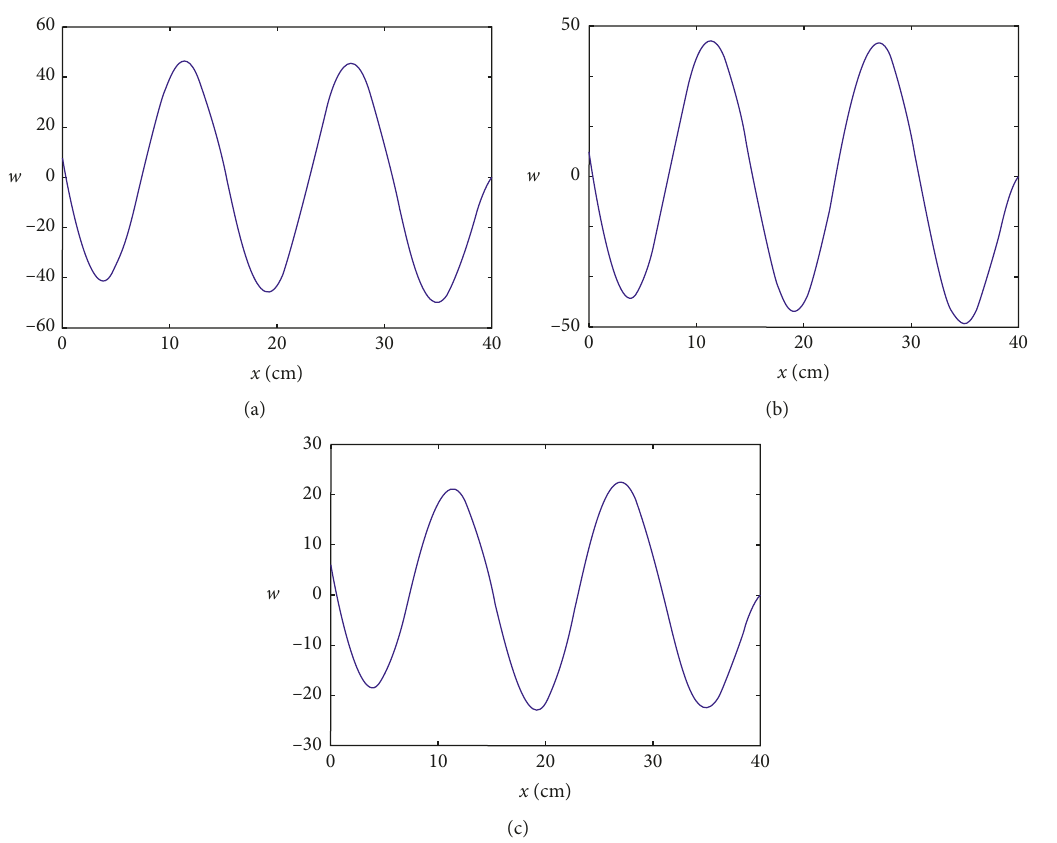
Figure 9: Effects of the damping layer thickness on acceleration responses: (a) ABH region ( x ( x m � 10 . 87